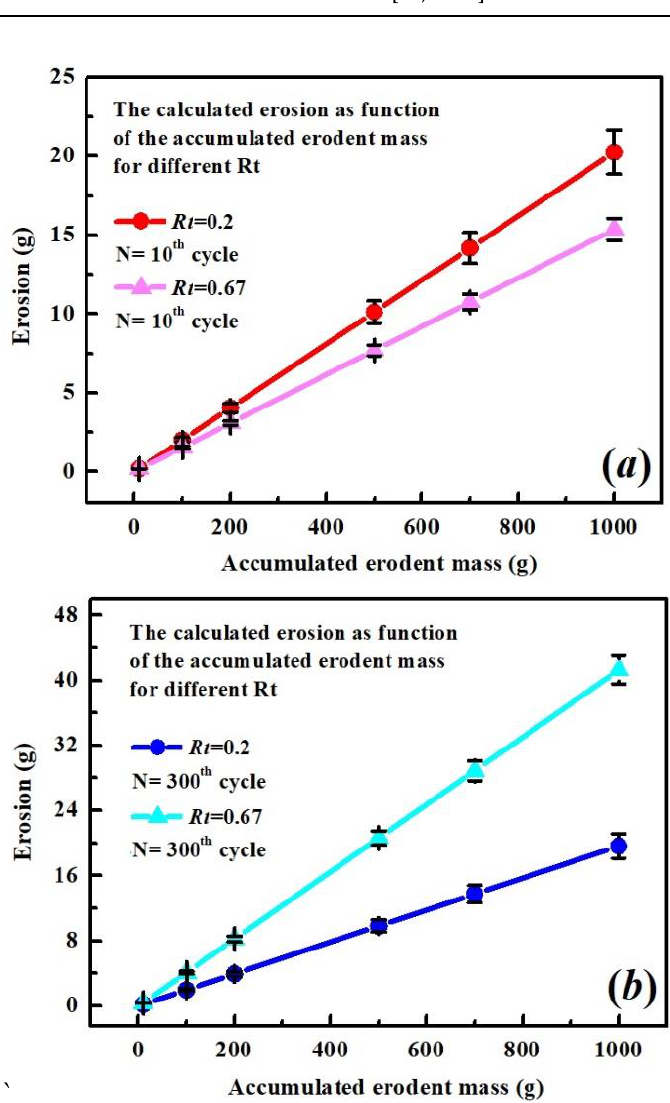
Figure 18. The calculated erosion versus accumulated mass with selected ratios R t at specific stages of thermal cycles; ( a ) N = 10, ( b ) N = 300. According to Figure 18a, higher erosion is obtained with a lower ratio R t , which indicates temperature-dependent erosion at the early stages of the thermal cycles.